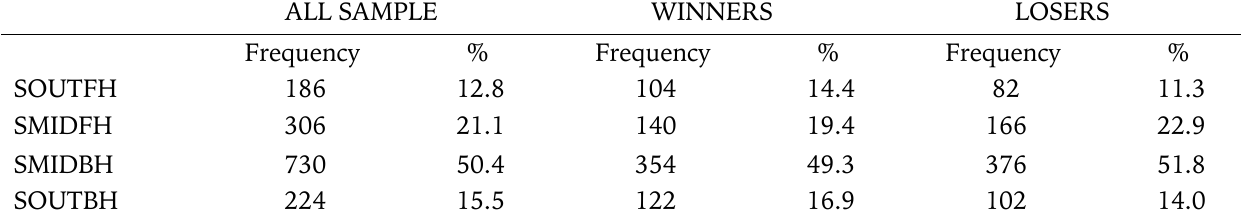
Results of analysis of serve placement of all sample and according result outcome (winners/losers) ALL SAMPLE